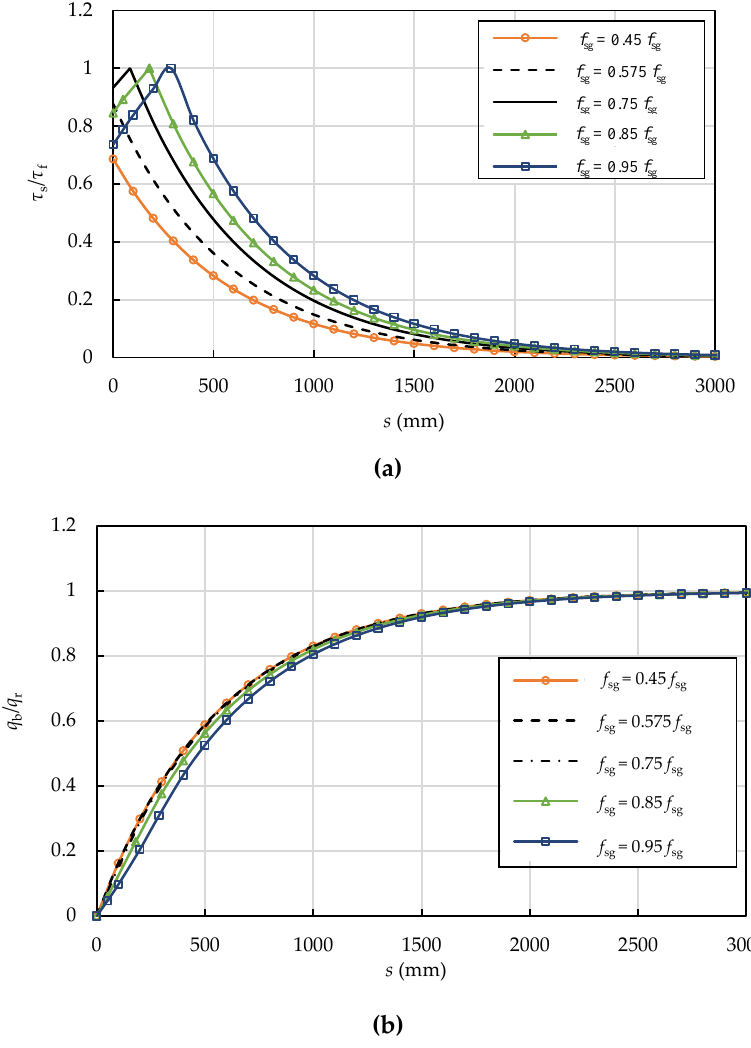
Figure 12. Effect of prestressing level on the ( a ) interfacial shear and ( b ) normal stress distributions ( τ f = 3.2 MPa, δ 1 = 3.0 mm, k = 0.5 and δ f = 6.6 mm).